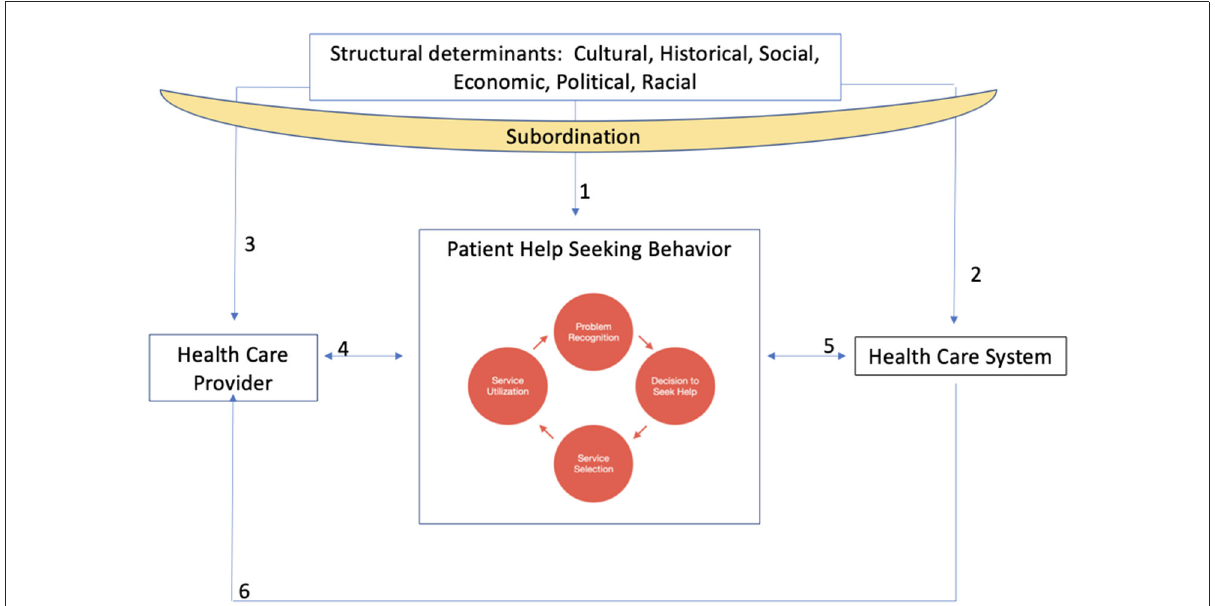
FIGURE1 Conceptual framework depicting relationships between structural determinants, subordination, and health care providers, patients and the health care system.